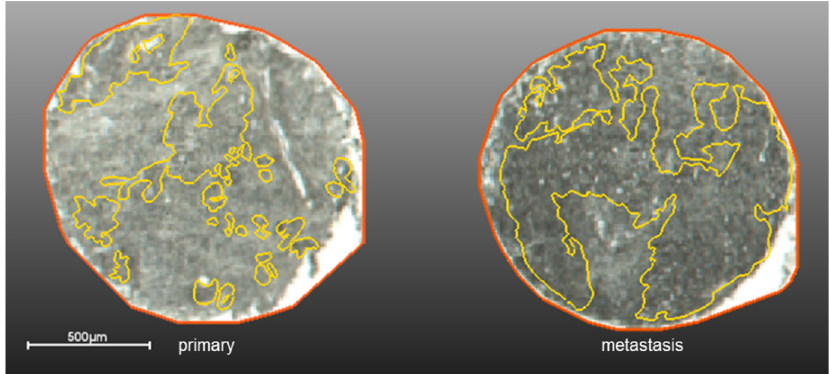
Figure 1. Example of histological annotation (in yellow) on the PDAC primary ( left ) and metastasis ( right ) TMA overlaid with the measurement regions (orange).